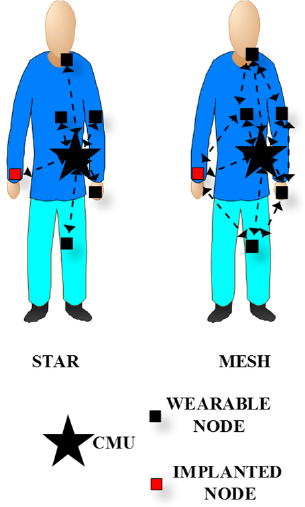
Figure 1. Wireless Body Sensor Network topology.